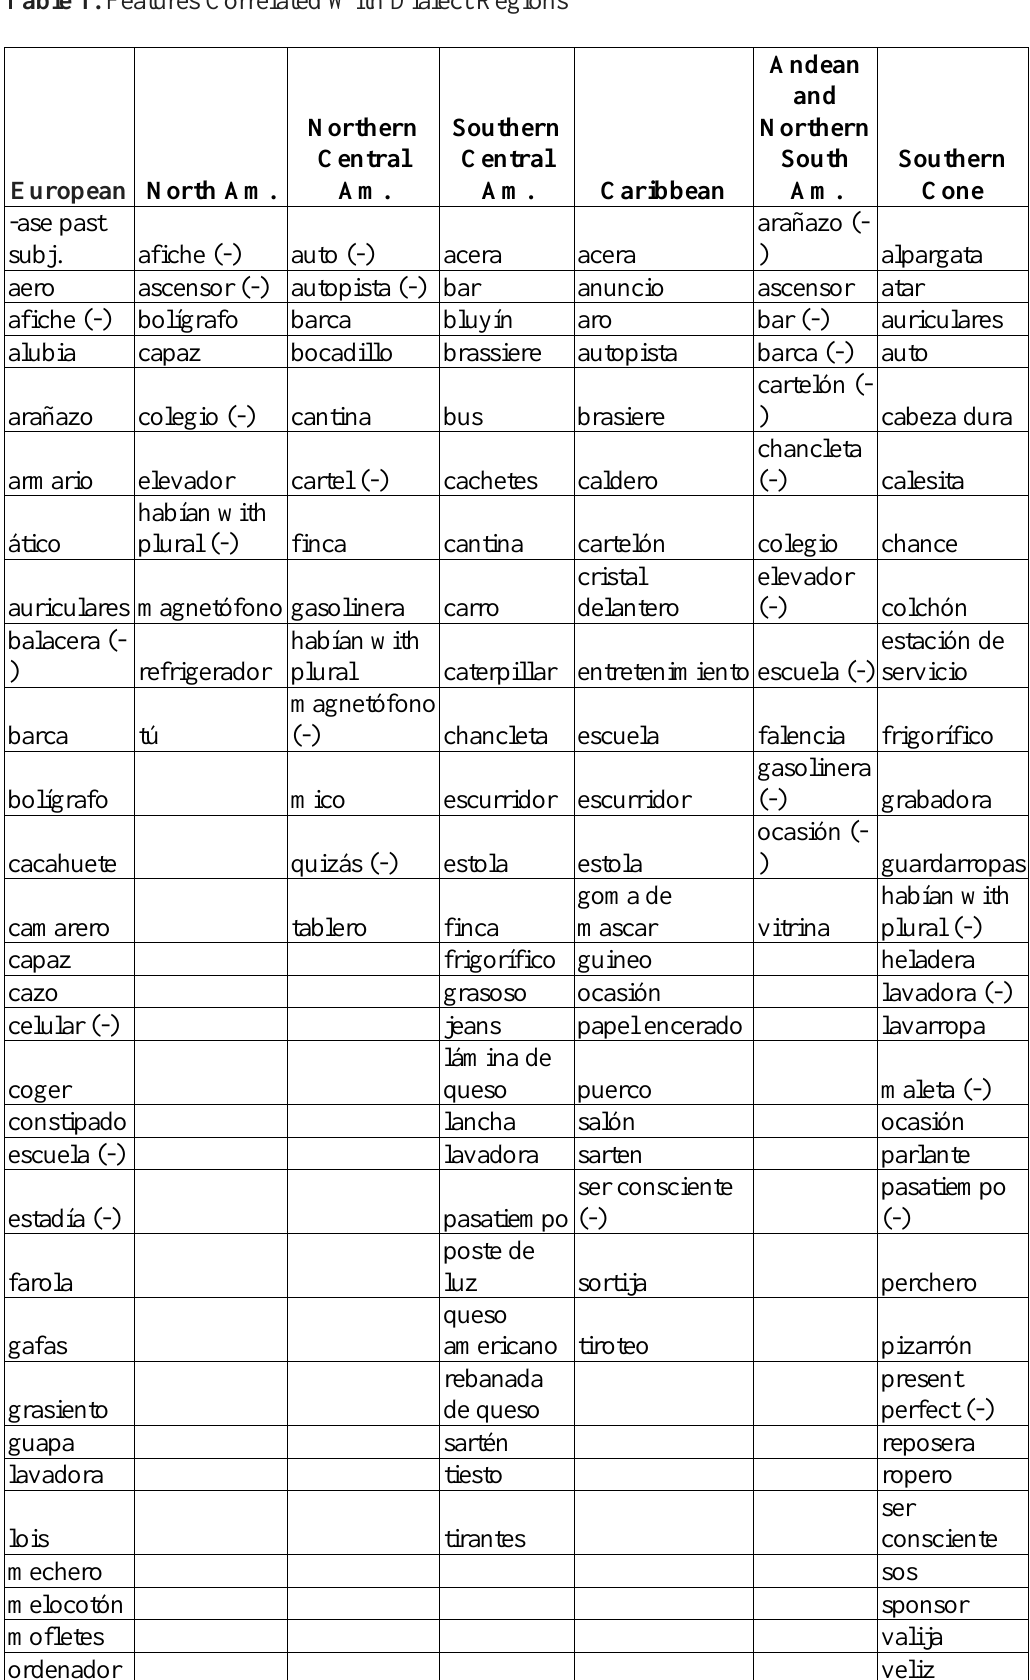
Table 1. Features Correlated With Dialect